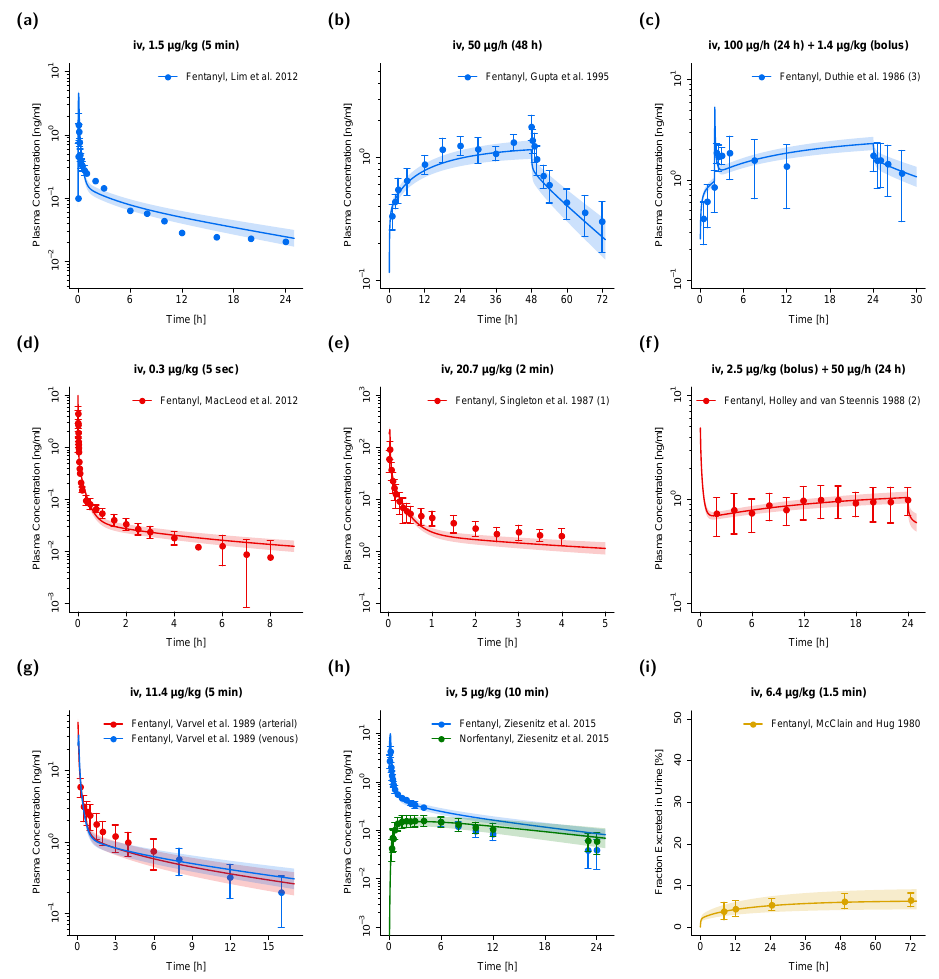
Figure 1. Fentanyl (blue: venous blood; red: arterial blood; orange: urine) and norfentanyl 1 (green: venous blood) predicted and observed plasma concentration–time as well as fraction excreted in urine–time profiles after intravenous administration of fentanyl in adults. ( a , c , e – g ): selection of external test dataset; ( b , d , h , i ): selection of internal training dataset. Population simulations ( n =